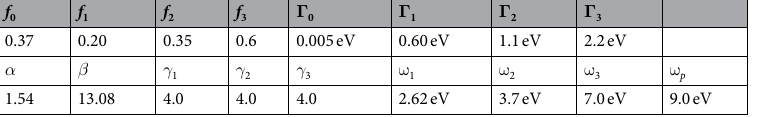
Table 1. Parameters for gold based on DCP model in Eq.